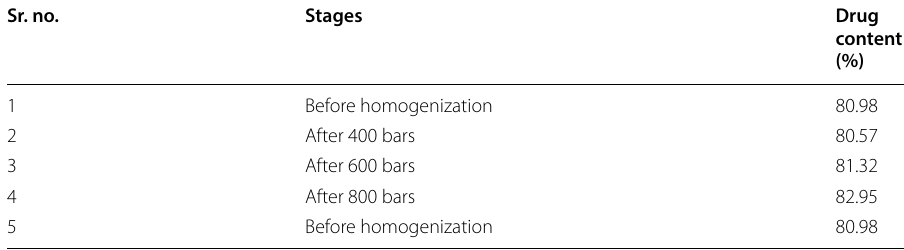
Table 3 Drug content in nanoemulsion Sr.